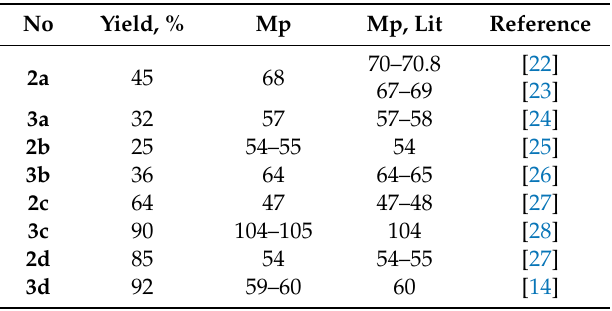
Table 1. Yields, mp and literature references for compounds 2a – d and 3a – d